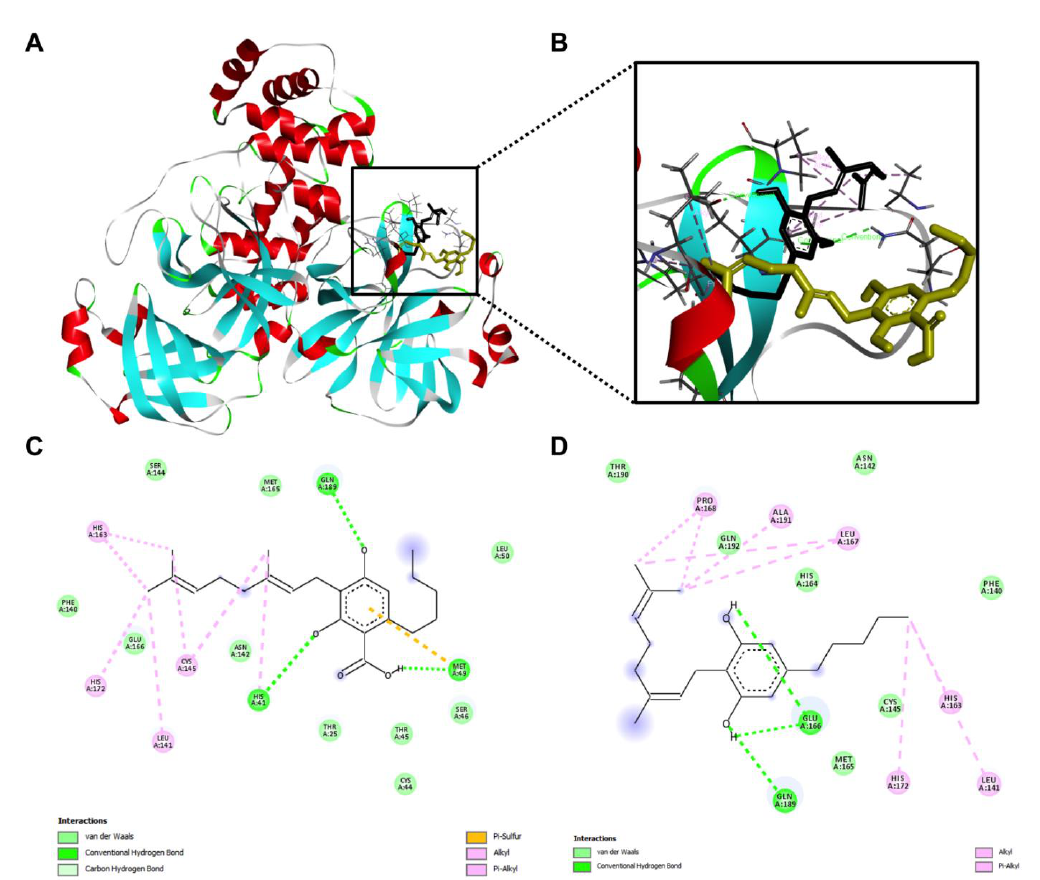
Figure 8. The overall view of the computational docking depicted interactions between the M pro protein and CBGA and CBG ( A ) and the zoom-in view of the ligand-protein interaction with CBGA (shown in golden) and CBG (shown in black) stacked with each other ( B ). Molecular forces formed between CBGA ( C ) or CBG ( D ) and the M pro protein.